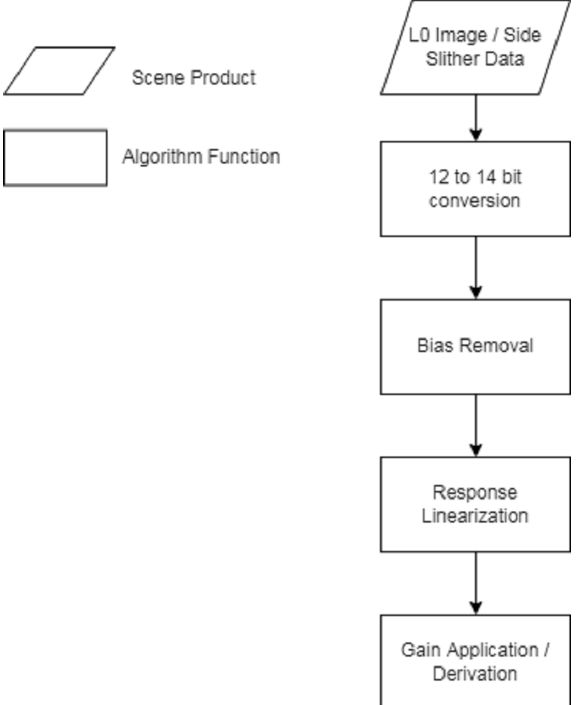
Figure 4. Summarized OLI radiometric processing overview used to prepare side-slither data for relative gain extraction and Level 0 or raw images for relative gain